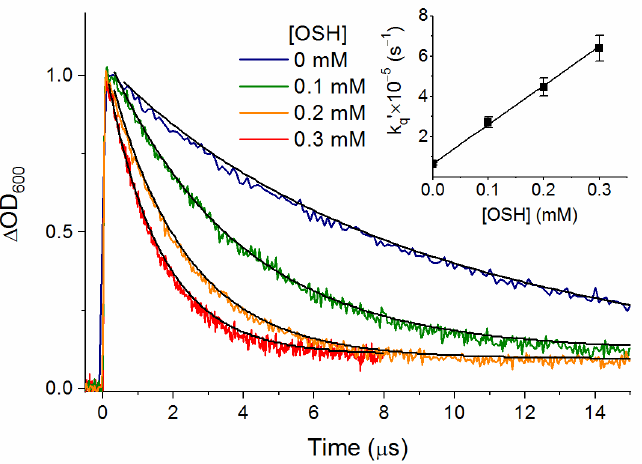
Figure 4. Normalized experimental and theoretical kinetic curves recorded at 600 nm during the T KNA decay at various OSH concentrations. Inset: Stern–Volmer plot for the pseudo-first rate constant k q ′ versus OSH concentration with the linear fit.